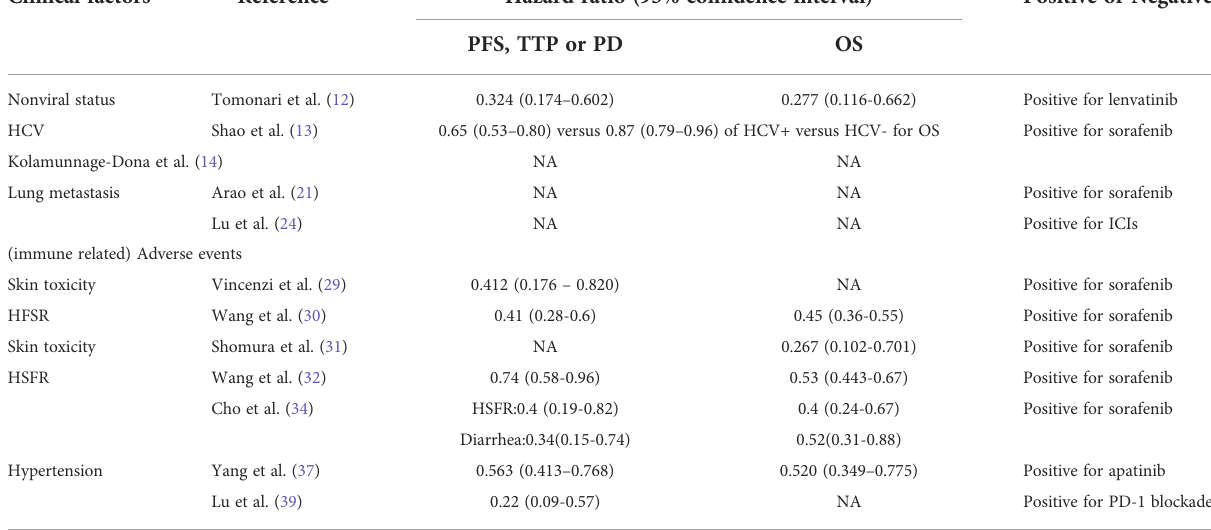
TABLE 1 Clinical Predictive factors for the systemic treatment of hepatocellular carcinoma. Clinical